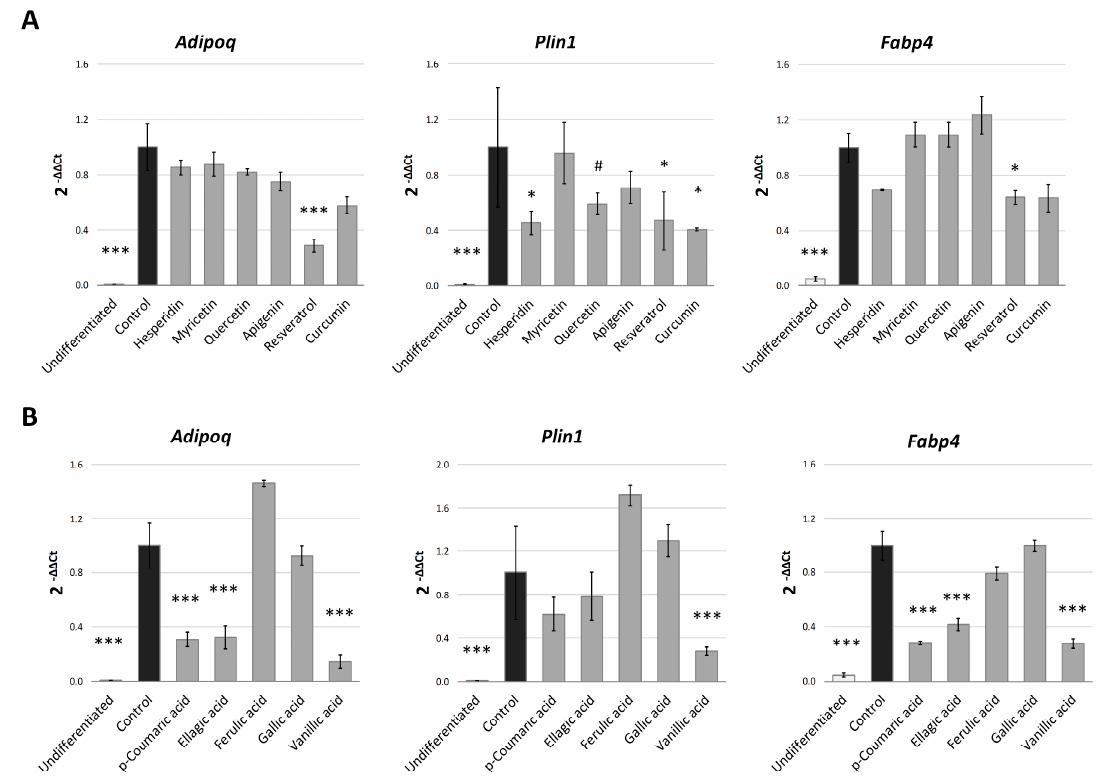
Figure 7. Gene expression analysis of PPAR γ -target genes after treatment (20 µM) with the different polyphenols ( A ) and phenolic acids ( B ). Results are expressed as the fold-difference expression levels of each gene in the treated group compared with the DMSO-control cells, calculated with the 2 −∆∆ Ct method. Significance refers to the effect of each treatment with respect to DMSO-control cells (* p < 0.05; ** p < 0.01; *** p < 0.001).